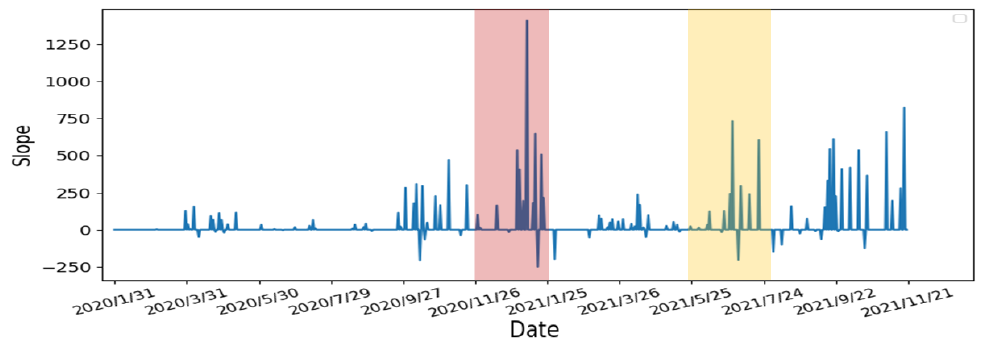
Figure 13. The slope of growing days in the UK’s Daily Confirmed Cases between 31 January 2020 and 21 November